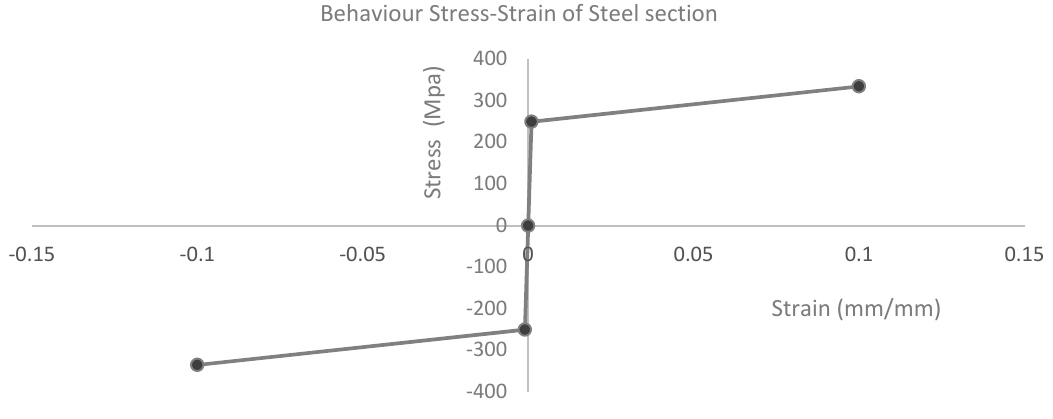
Figure 9. Stress–strain diagram of steel for the cross-section.